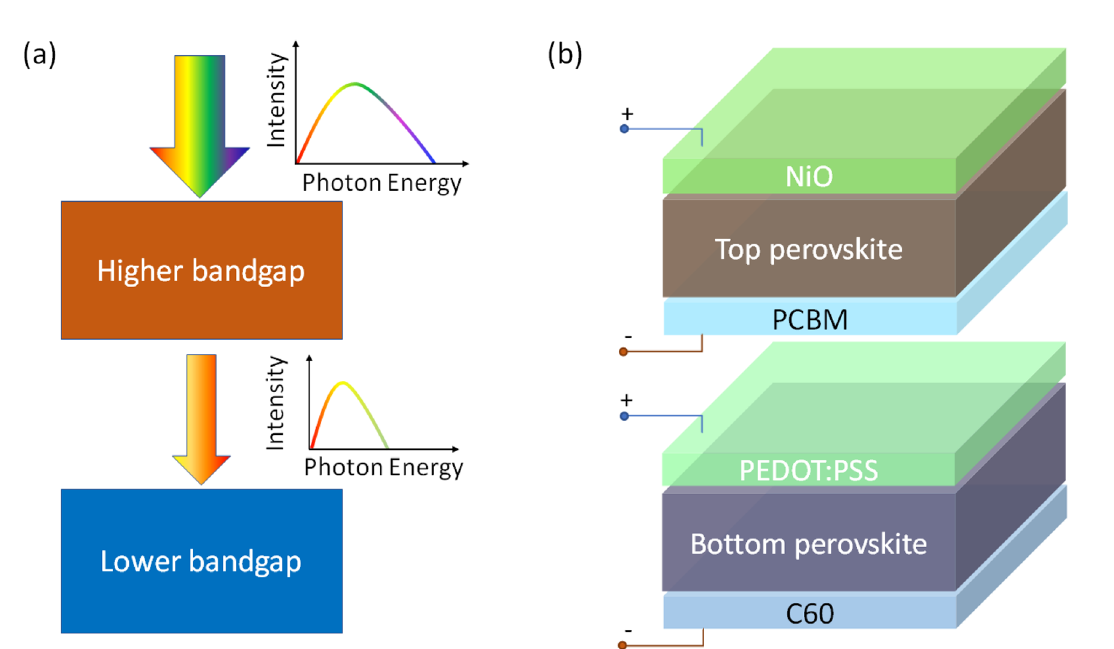
absorber. The buffers can host defect states and traps, leading to recombination losses.